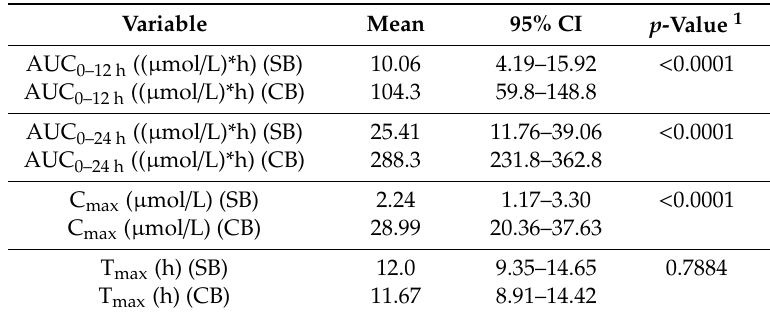
Table 5. Pharmacokinetic parameters of TMAO.